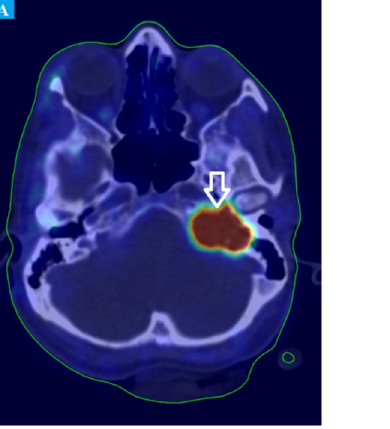
Figure 2. ( A ) combined 68 GA-DOTATE PET and CT images showing a large, highly metabolically active mass in the skull; ( B ) CT scan showing a polycystic tumor compressing the left cerebellar tonsil; ( C ) combined MR and CT scan showing infiltration of the left sublingual nerve extending to the left internal carotid artery canal and obstructing the left internal jugular vein at the inferior bulb region.